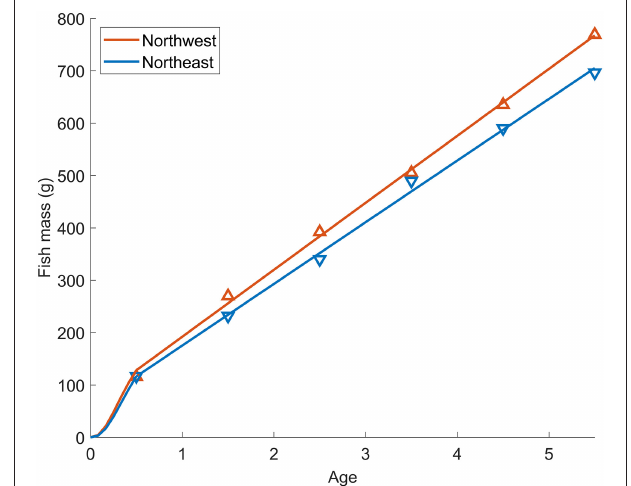
FIGURE 6 | Relationship between fish age and mass for Pacific chub mackerel from the Northwest (red) and Northeast (blue) stocks. Triangle markers are the mean mass at age 0–5 for the Northwest stock during 1970–2018 and Northeast stock during 1983–2018. Lines-of-best-fit from age 0–5 represent the relationship of age ( t ) and mass ( W ) of Northwest stock: W = 123 t + 64.2 ( n = 294, r 2 = 0.838, p < 0.0001) and Northeast stock : W = 117 t + 57.5 ( n = 216, r 2 = 0.911, p < 0.0001). The growth curves for the first 6 months are shown as Gompertz functions: W = 207[ e − e − 3.85 ( t + 0.010 ) ] 3.16 for Northwest stock, and W = 218[ e − e − 3.36 ( t + 0.011 ) ] 3.16 for Northeast